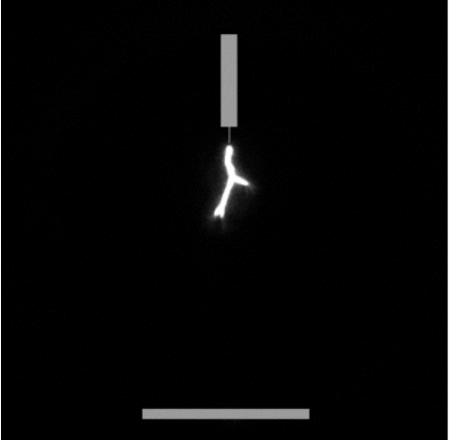
Figure 11. Photo (experiments) [31] of leader discharges in SF 6 at 1 bar in point to plane configuration. Needle radius of curvature = 0.2 mm, gap distance = 50 mm. Applied voltage = 107